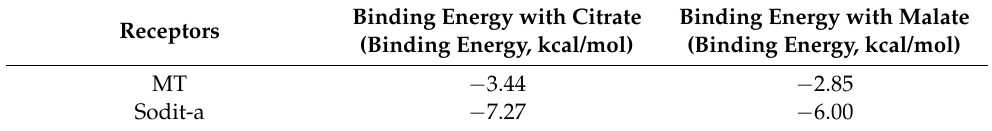
Figure 5. Active site interacting residues of modelled MT protein form in the docked structure with ( a ) greenish-blue and green colour ribbons representing modelled MT with citric acid, or ( b ) greenish-blue and red colour ribbons representing modelled MT with malic acid, respectively. Table 1. Binding energies of docked ligands.